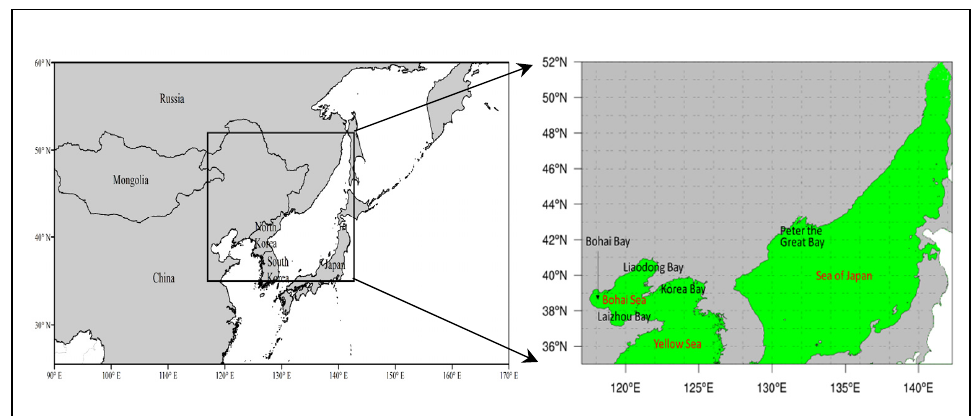
Figure 1. The study region.